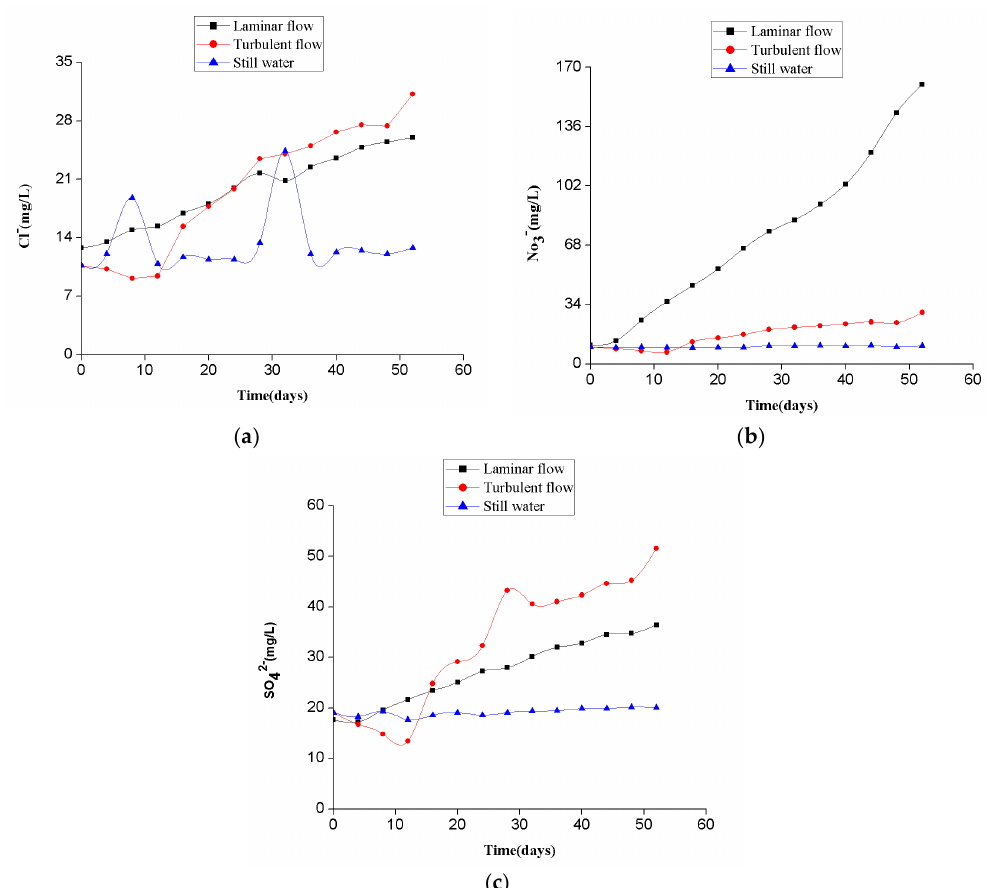
Figure 8. Curves of the main anion concentrations in circulating aqueous solution under different flow patterns ( a ) Concentration variation of Cl − ; ( b ) Concentration variation of NO 3 − ; ( c ) Concentration variation of SO 42 − .